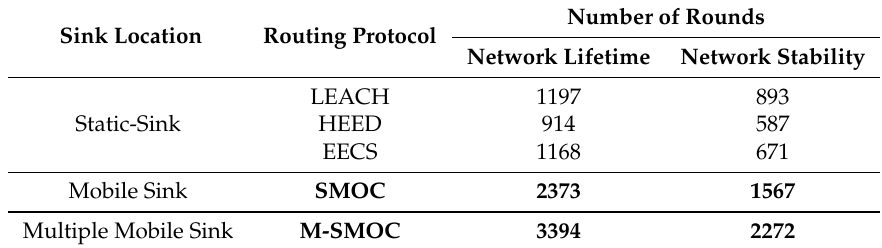
Table 2. Performance comparison of SMOC and M-SMOC with existing static sink routing